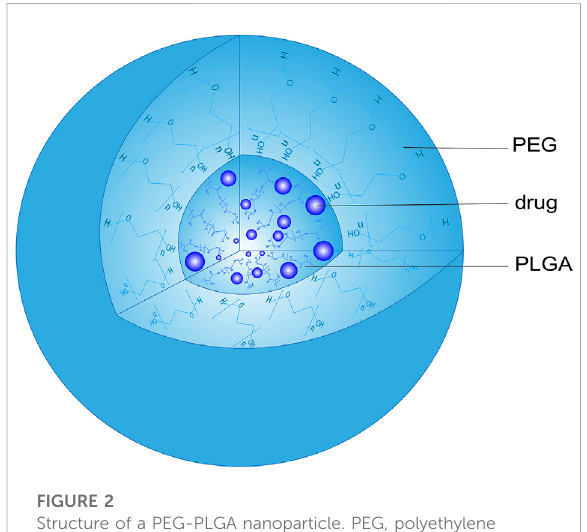
FIGURE 2 Structure of a PEG-PLGA nanoparticle. PEG, polyethylene glycol; PLGA, poly (lactic acid-co-glycolic